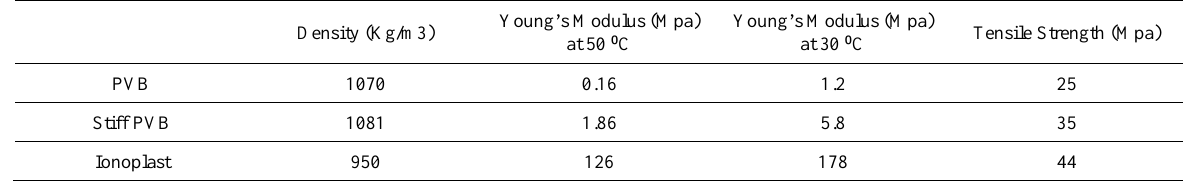
Table 1: Young’s Modulus and